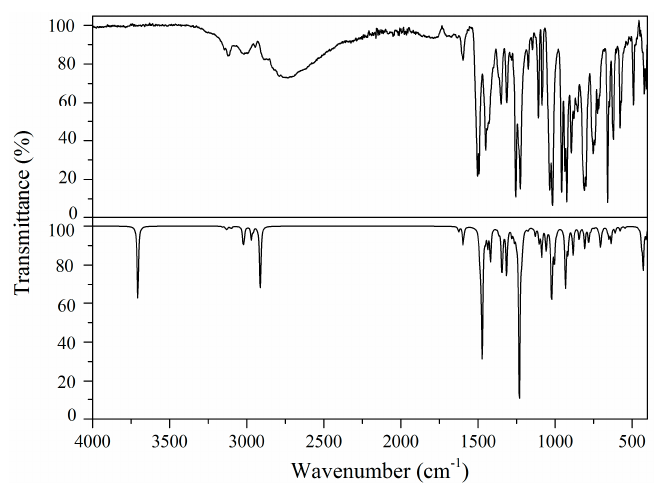
Figure 5. Experimental ( upper ) and simulated (lower ) FT-IR spectra of compound 4 .